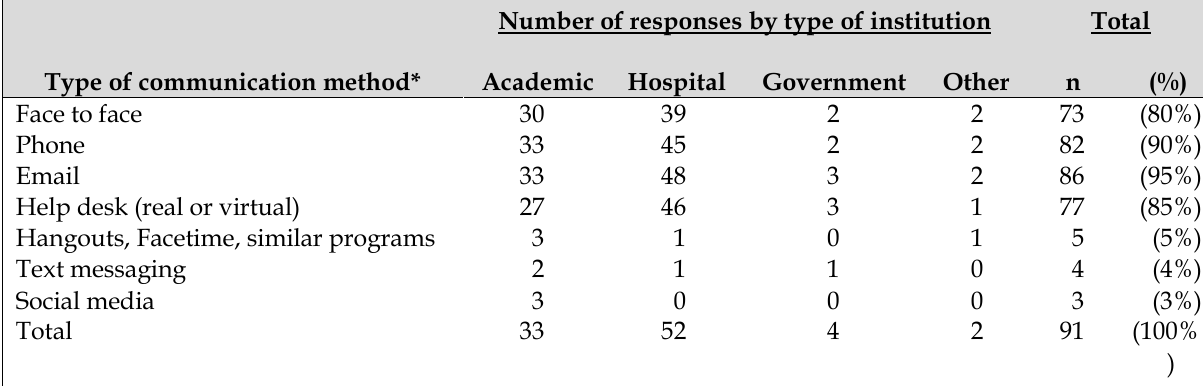
Table 3 Communication methods between libraries and IT